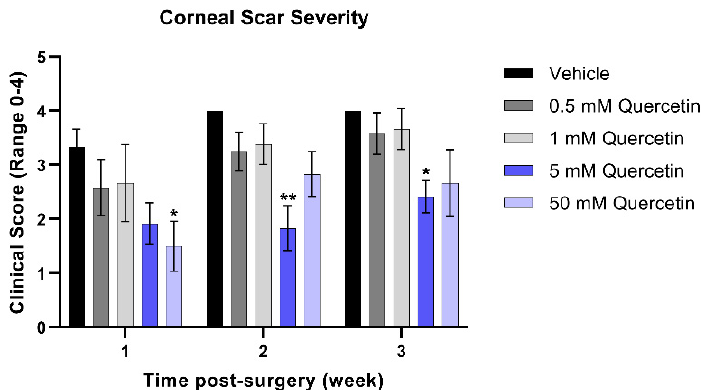
Figure 3. Clinical scoring of corneal scar severity. Quercetin-treated groups were compared to the vehicle-treated group at the same-timepoint. Statistical significance based on a two-way ANOVA with Šídák’s multiple comparisons test (* p < 0.05 and ** p < 0.01). Bars represent mean ± standard error of the mean with n = 3 clinical scores per eye.